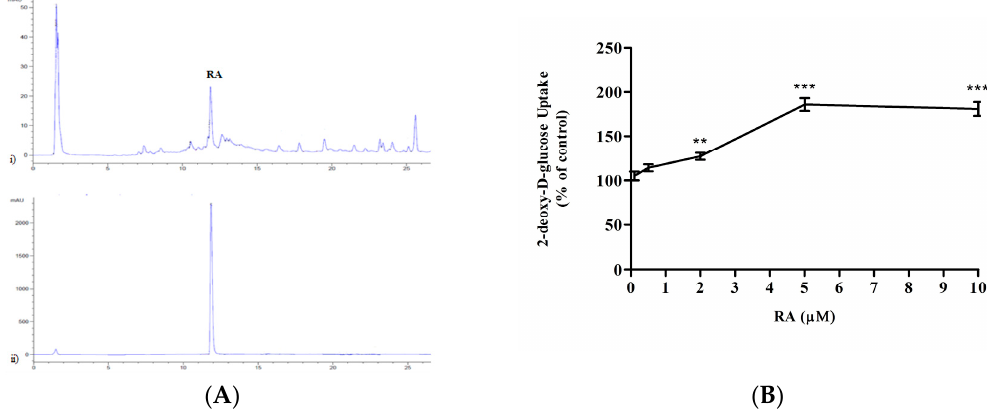
Figure 1. ( A ) Levels of rosmarinic acid (RA) present in rosemary extract (RE). High-performance liquid chromatography (HPLC) chromatograph representing RE (upper panel) and RA standard (lower panel). ( B ) Effects of rosmarinic acid (RA) on glucose uptake (dose response). Serum-deprived L6 myotubes were incubated without or with 0.1, 0.5, 2, 5 or 10 µM RA for 4 h. 2-deoxy- D -glucose uptake was measured according to the methods. Data are expressed as percentage of control. Results are the mean ± SE of 3–4 independent experiments. ** p < 0.01, *** p < 0.001, vs control.